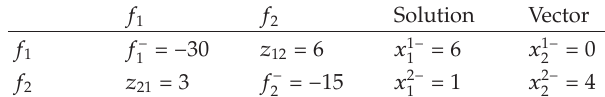
Table 4: Second pay-o ff table of Section